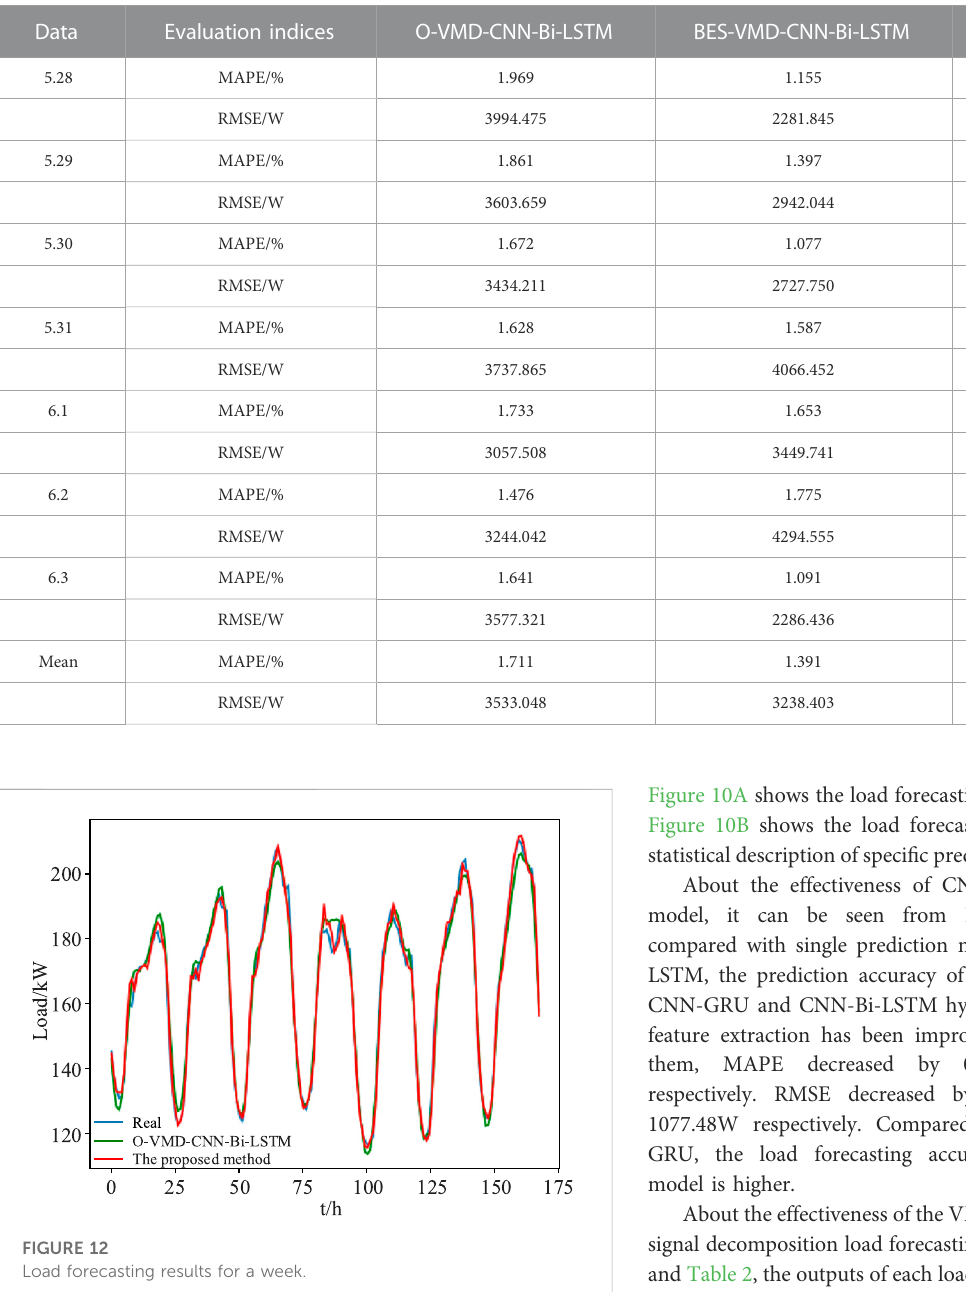
TABLE 4 Comparison of statistical results of load forecasting errors for a week.